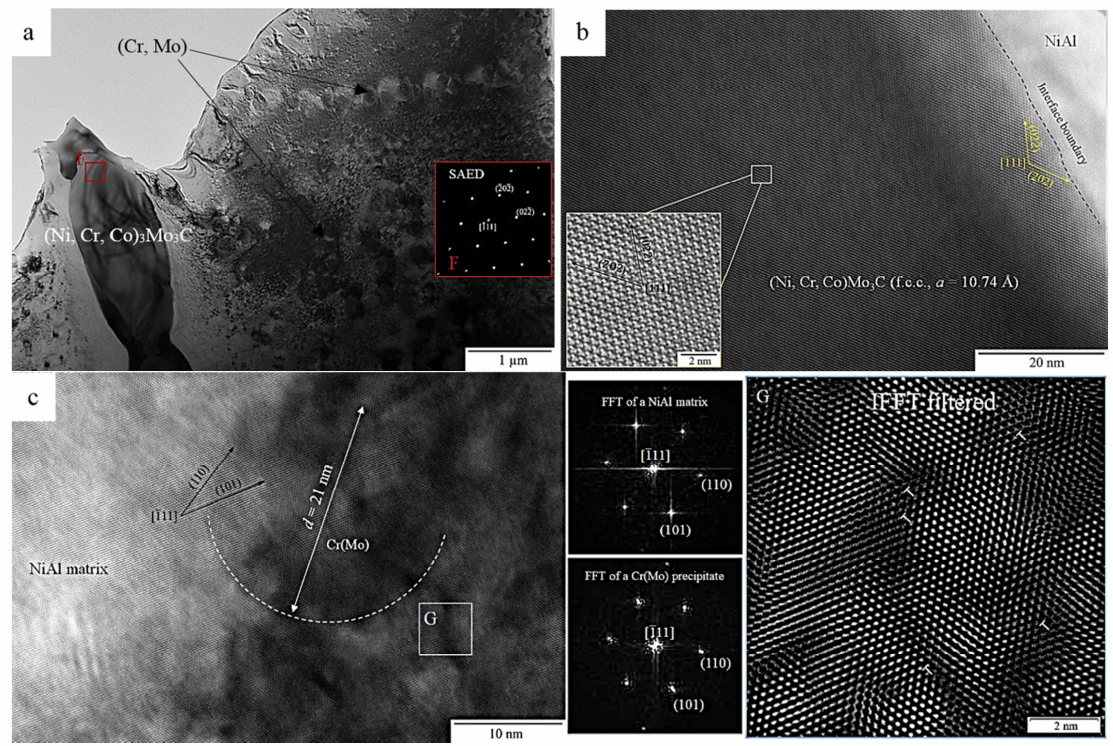
Figure 18. ( a ) The BF TEM structure of the NiAl-15Mo-12Cr-6Co alloy after annealing at 1250 ◦ C with a [111] SAED inset (marked with F) from (Ni,Co,Cr) 3 Mo 3 C phase. ( b ) The HRTEM image of the crystal structure of the (Ni,Co,Cr) 3 Mo 3 C phase near the interface with the β -NiAl dendritic cell. ( c ) The crystal structure of β -NiAl cell and Cr(Mo) precipitate along the [111] zone axis. The FFT pattern from the β -NiAl matrix and Cr(Mo) precipitate. The [111] IFFT filtered area is marked with G.